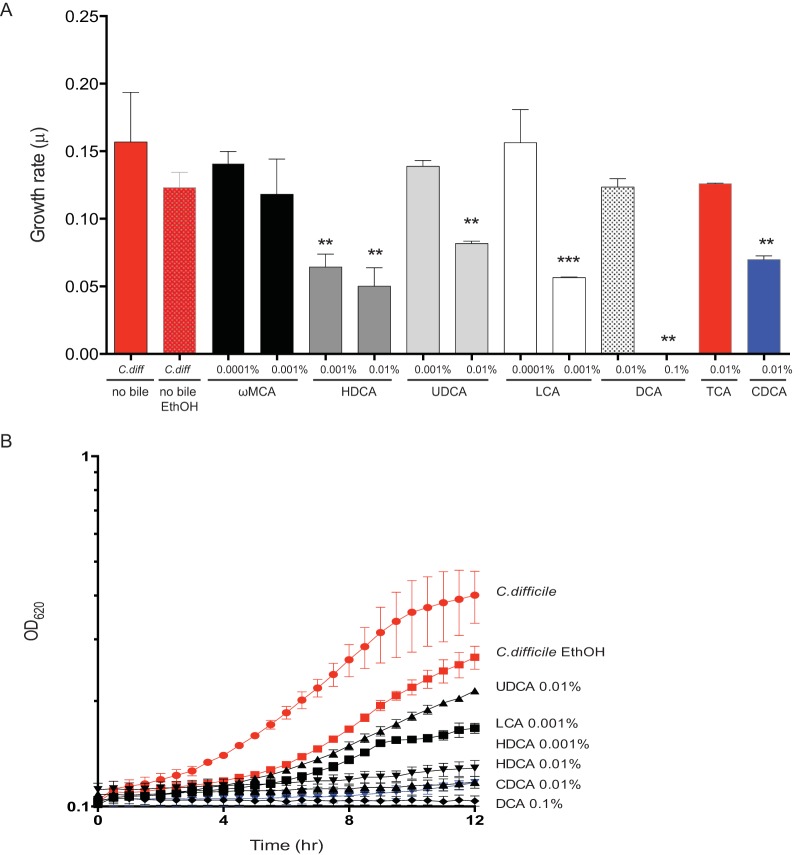
Secondary bile acids present during C. difficile resistance inhibit growth of C. difficile. (A) Growth rates (per hour) are shown. C. difficile was grown in BHI medium supplemented with various secondary bile acids with a range of in vivo concentrations (0.001% to 0.1%) present during resistance to C. difficile. The data presented represent the means ± SD from triplicate experiments and were significant compared to positive controls C. difficile and C. difficile with mock ethanol (EthOH) without bile acids (Students t test, **, P < 0.05; ***, P < 0.01). (B) Growth curve of representative secondary bile acids that significantly decreased the growth rate of C. difficile in panel A.